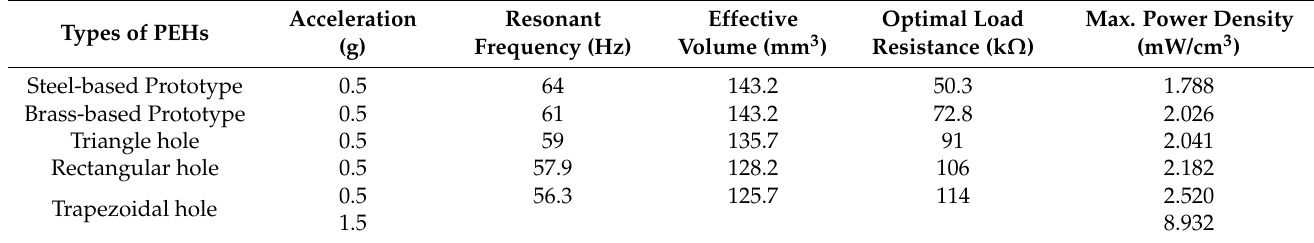
Table 3. Comparison of the performance of various types of